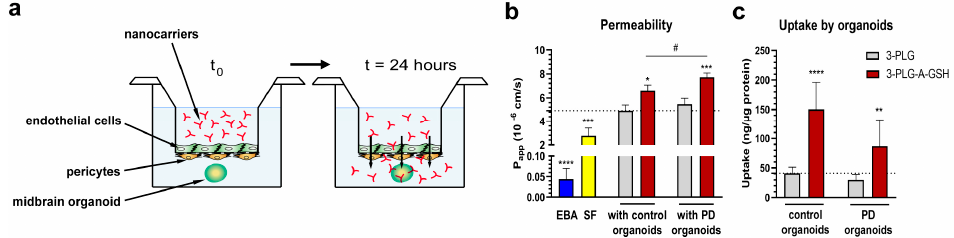
Figure 9. Permeability of non-targeted (3-PLG) and alanine-glutathione-targeted (3-PLG-A-GSH) nanocarriers across the human co-culture model of the blood–brain barrier and entry into midbrain- specific organoids (24 h, 100 μ g/mL, 37 °C). ( a ) Schematic drawing of the experimental set-up. ( b ) Permeability of Evans blue-albumin (EBA) and sodium fluorescein (SF) reference marker molecules across the BBB model. Permeability of 3-PLG and 3-PLG-A-GSH across the co-culture model in the presence of midbrain-specific organoids derived from healthy control and from Parkinson’s disease (PD) patients’ cells. ( c ) Cellular uptake of 3-PLG and 3-PLG-A-GSH by organoids after crossing the blood–brain barrier. Values are means ± SD, n = 6. Statistical analysis: two-way ANOVA, Dunnett test. * p < 0.05, ** p < 0.01, *** p < 0.001, **** p < 0.0001 compared to the 3-PLG data in both organoid groups; # p < 0.05 compared between organoid groups. Permeability values of EBA and SF were compared to the 3-PLG group with control organoids (*** p < 0.001, **** p < 0.0001; one-way ANOVA, Dunnett test). P app : apparent permeability coefficient.